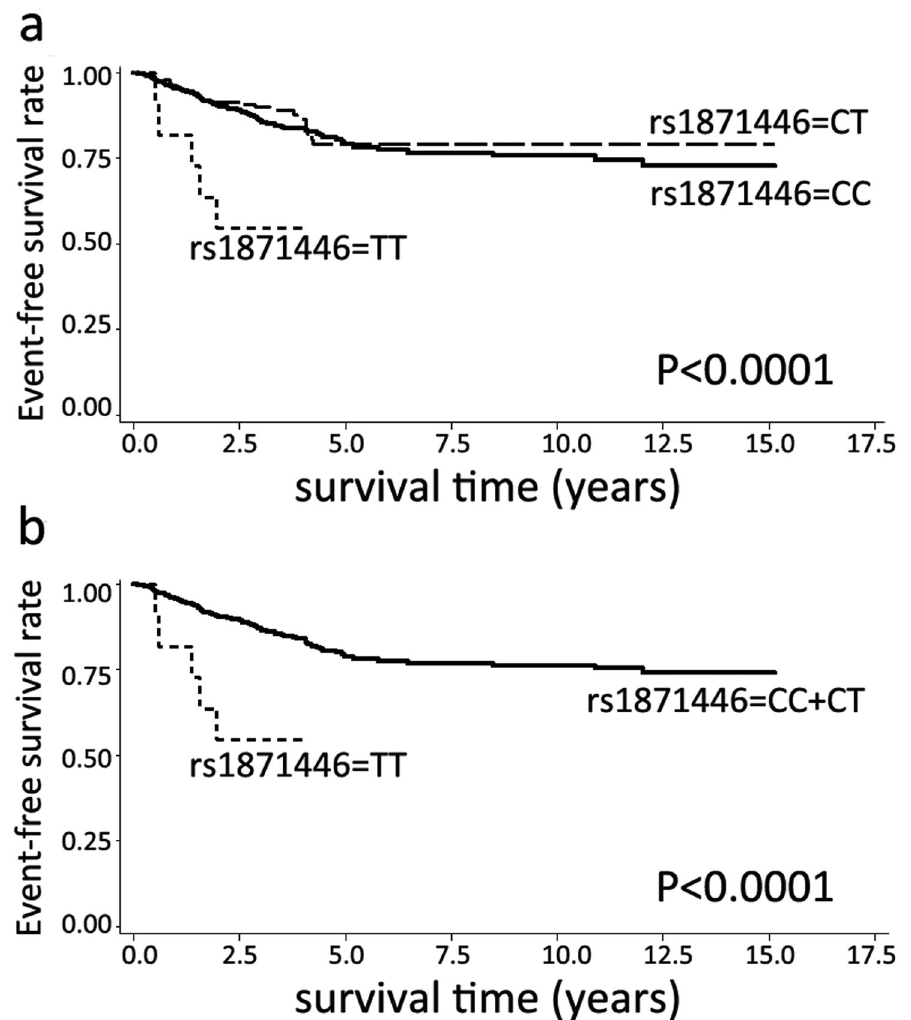
Figure 2. Kaplan-Meier estimates of event-free survival according to rs1871446